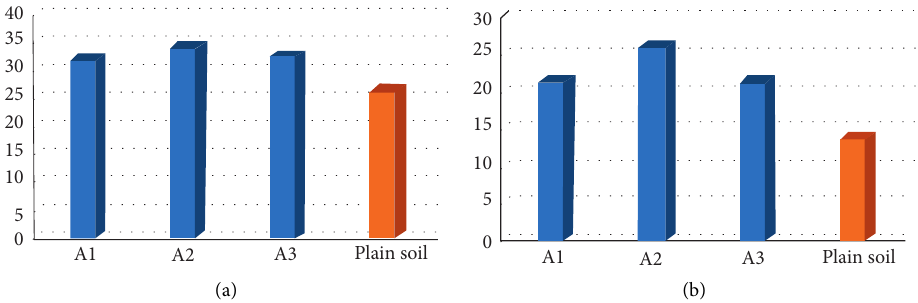
Figure 19: Variation in shear strength of different reinforced soils. (a) Internal friction angle. (b)